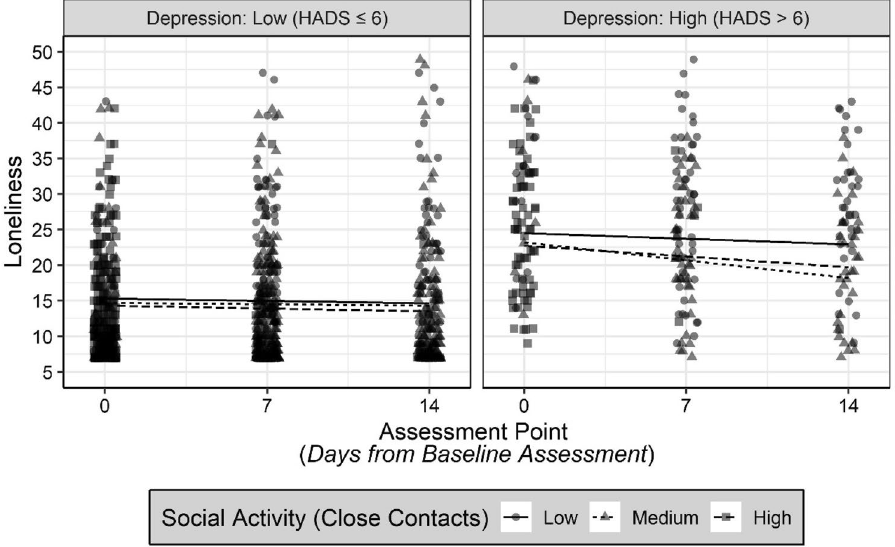
Figure 1. Visualisation of data drawn from one randomly selected imputed dataset depicting the relationship between social interaction frequency with close contacts and loneliness, at each assessment point for participants in the high depression group and low depression